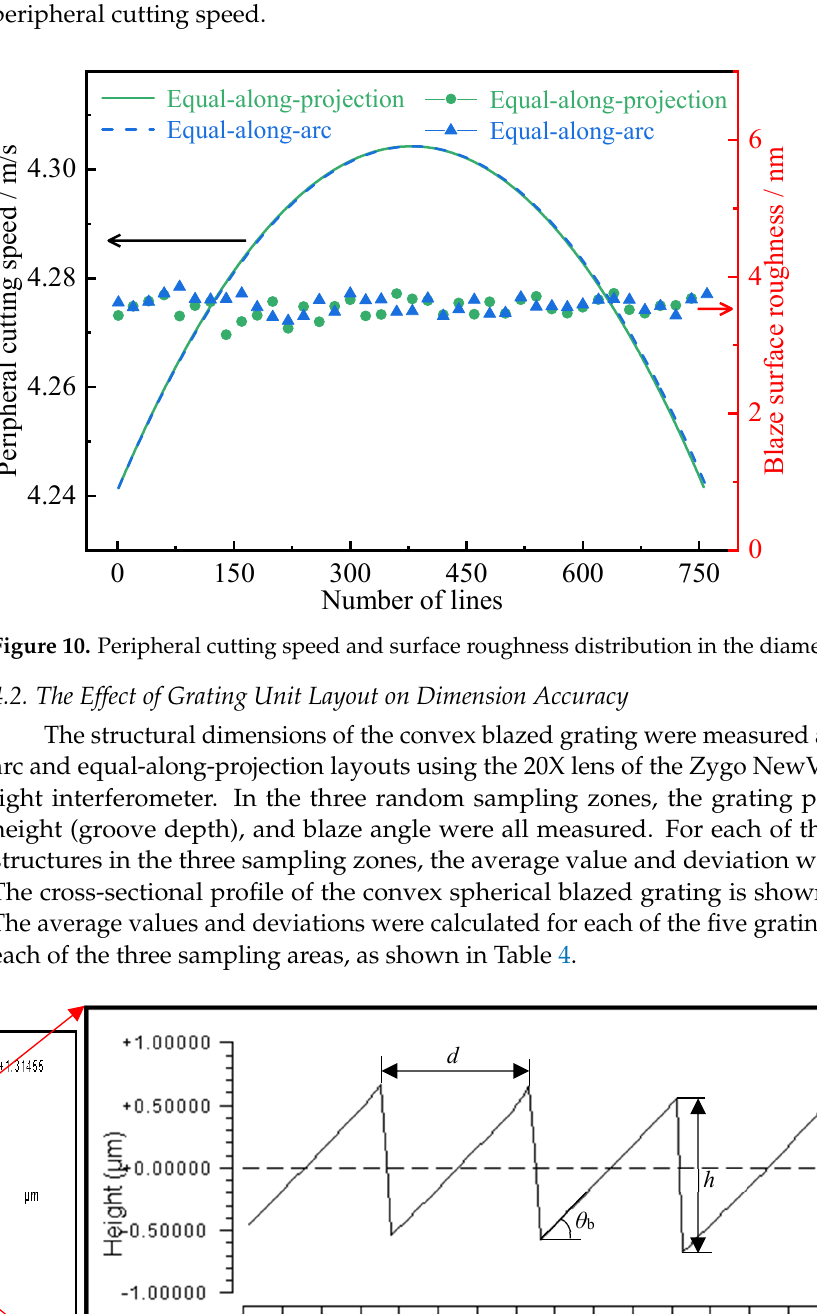
Figure 11. Measurements for grating period, grating height, and blaze angle of blazed grating. Table 4. Dimensions and roughness measurements of convex spherical blazed grating elements. Grating Layouts